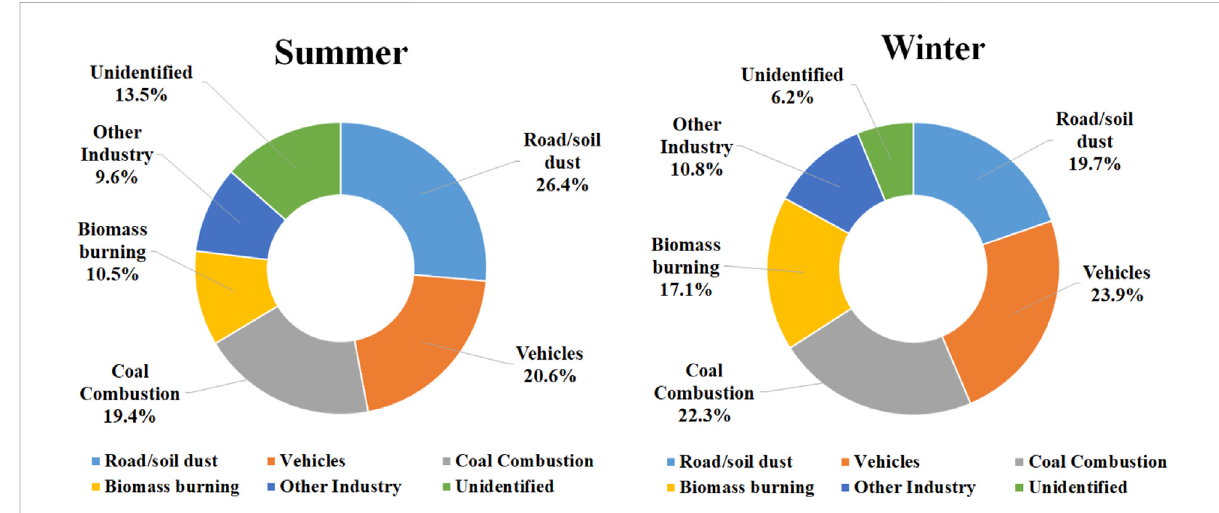
FIGURE 7 Results of source apportionment of PM concentrations during summer and